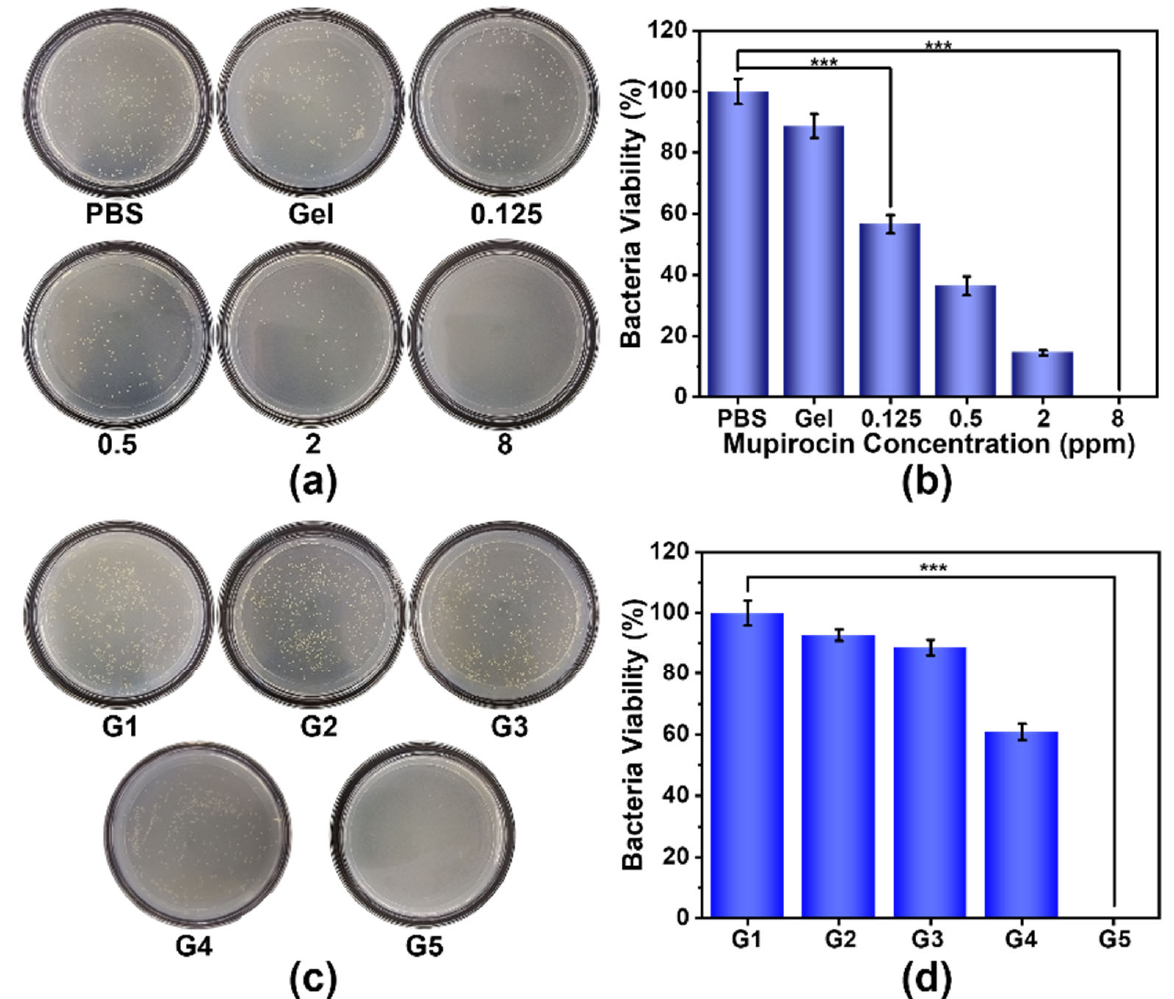
Figure 4. Antibacterial evaluation of mono/synergistic therapy in vitro . Results of ( a ) standard plate counting and ( b ) survival percentages of MRSA after 24 h of incubation with PBS, Gel, and M@Gels with mupirocin concentrations of 0.125, 0.5, 2, and 8 ppm, respectively. Results of ( c ) standard plate counting and ( d ) survival percentages of MRSA after 24 h of mono/synergistic treatments. G1: PBS, G2: Gel, G3: C@Gel with NIR, G4: M@Gel, G5: C/M@Gel with NIR. Mupirocin concentration in M@Gel and C/M@Gel: 0.125 ppm, Cu concentration in C@Gel and C/M@Gel: 24 ppm. (Error bar: